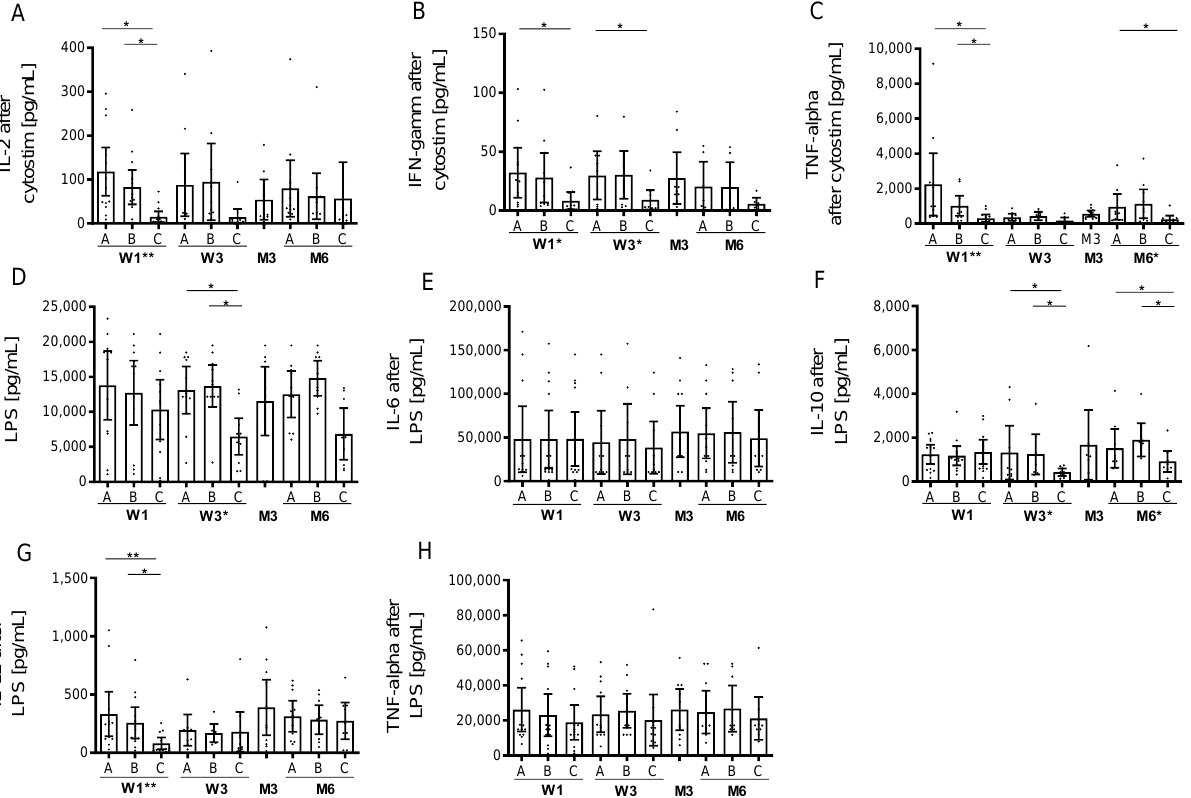
Figure 3. Cytokine release upon stimulation of cells during OCR treatment. Cytokine levels in cultured cell supernatants after ex vivo cytostim stimulation ( A – C ) and after ex vivo LPS stimula- tion ( D – H ) are depicted ( n = 13). Analysis was performed at baseline [A], after MP [B], after OCR [C] at week 1 (W1) and week 3 (W3), month 3 (M3) and month 6 (M6). Mean values with 95% CI are presented. Asterisks indicate a statistically significant difference between selected time points and global effects (* p < 0.05, ** p < 0.01).